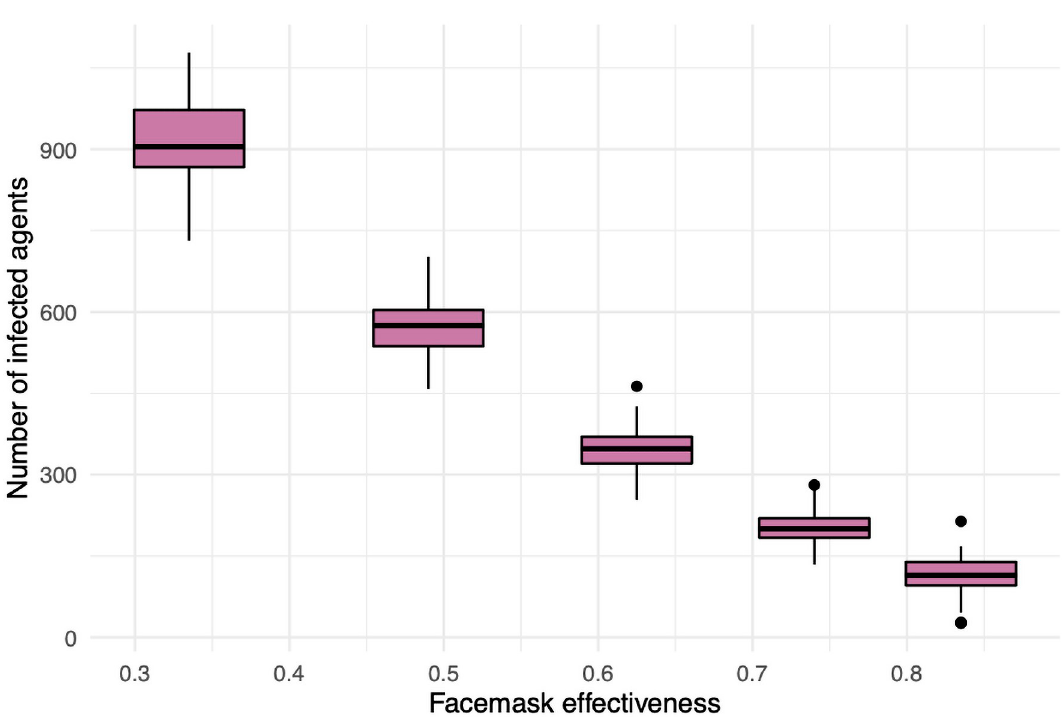
Fig 12. A sensitivity analysis of facemask effectiveness. Displayed are total number of infections after a semester with f ¼ 1 (perfect facemask compliance), but no other intervention.